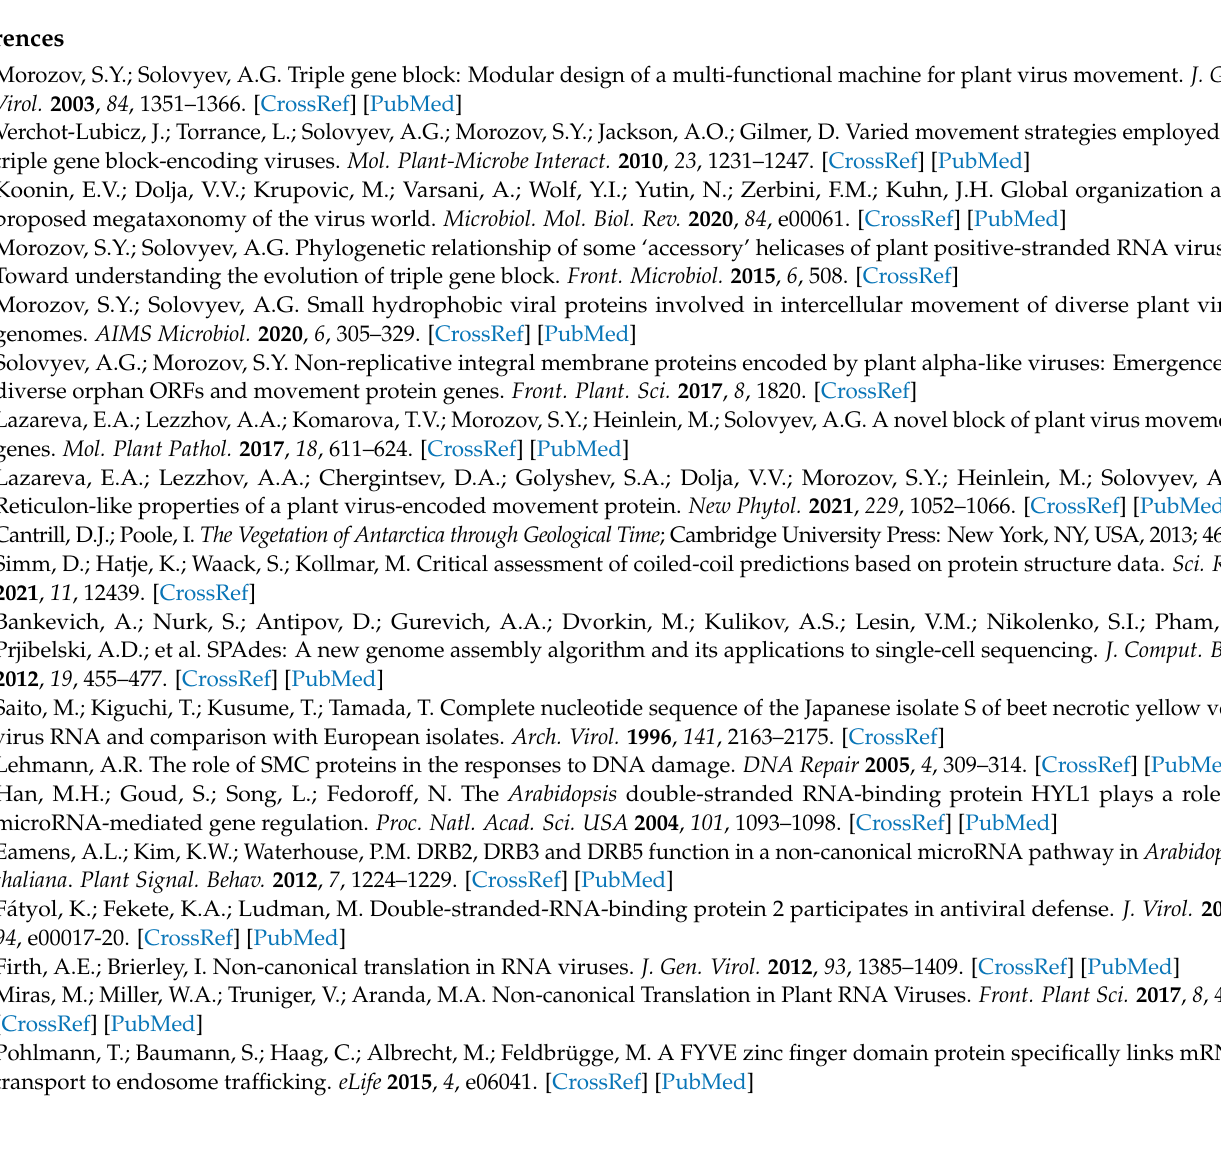
Figure S2: Nucleotide sequence of Cq-VLRA 2; Figure S3: Full-length translation of Ds-VLRA 1 in RdRp frame (first Met residue is in green; GDD signature is in yellow; termination codons are marked as